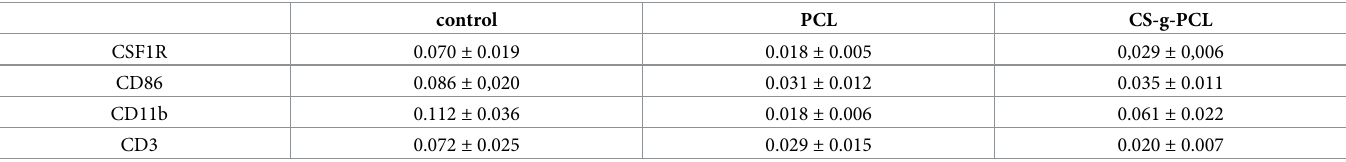
Table 4. Results from quantification of immunofluorescent detection of immune cell